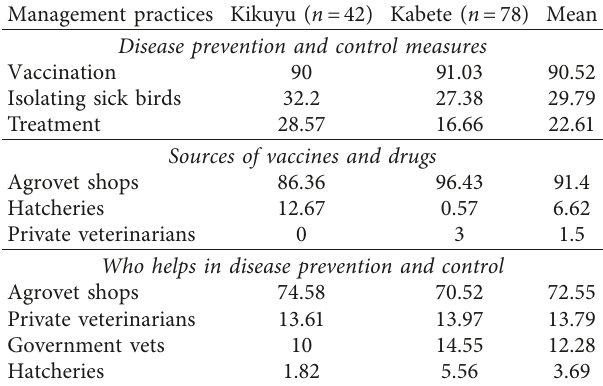
Table 7: Management practices used by farmers in the study area (%).